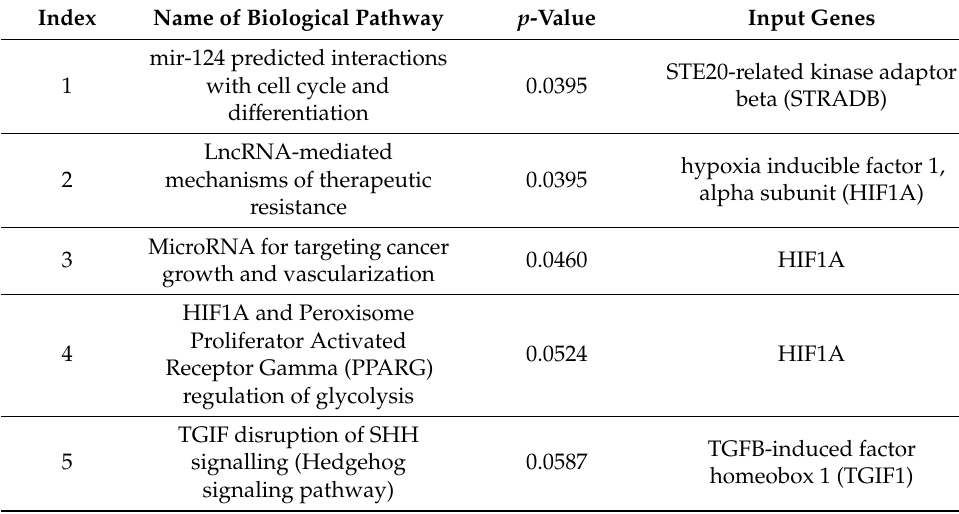
Table 5. Top 10 biological pathways most significantly associated with di ff erentially expressed genes after 10 nM bisphenol A (BPA) treatment of syncytialised BeWo cells using the WikiPathways 2019 database